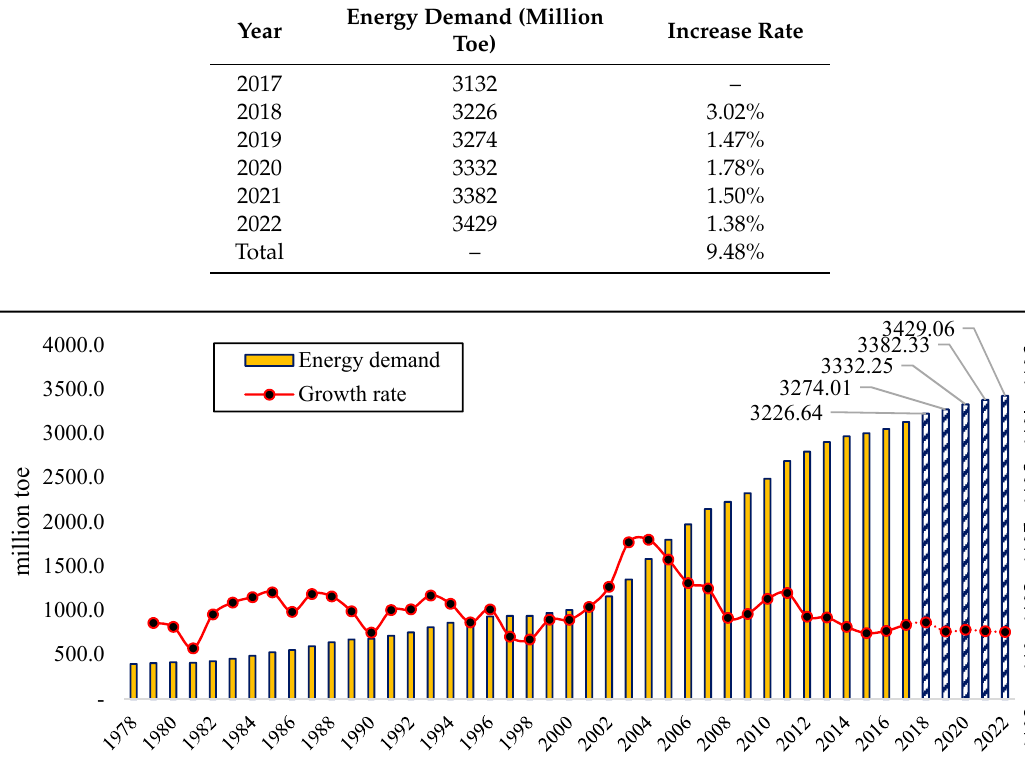
Table 8. Forecasting results of the future energy demand by the E_ABC model.